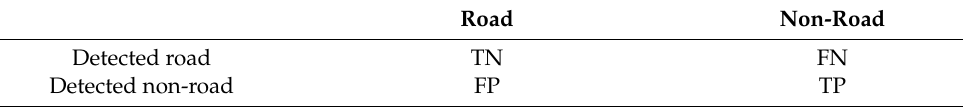
Table 1. Contingency table.